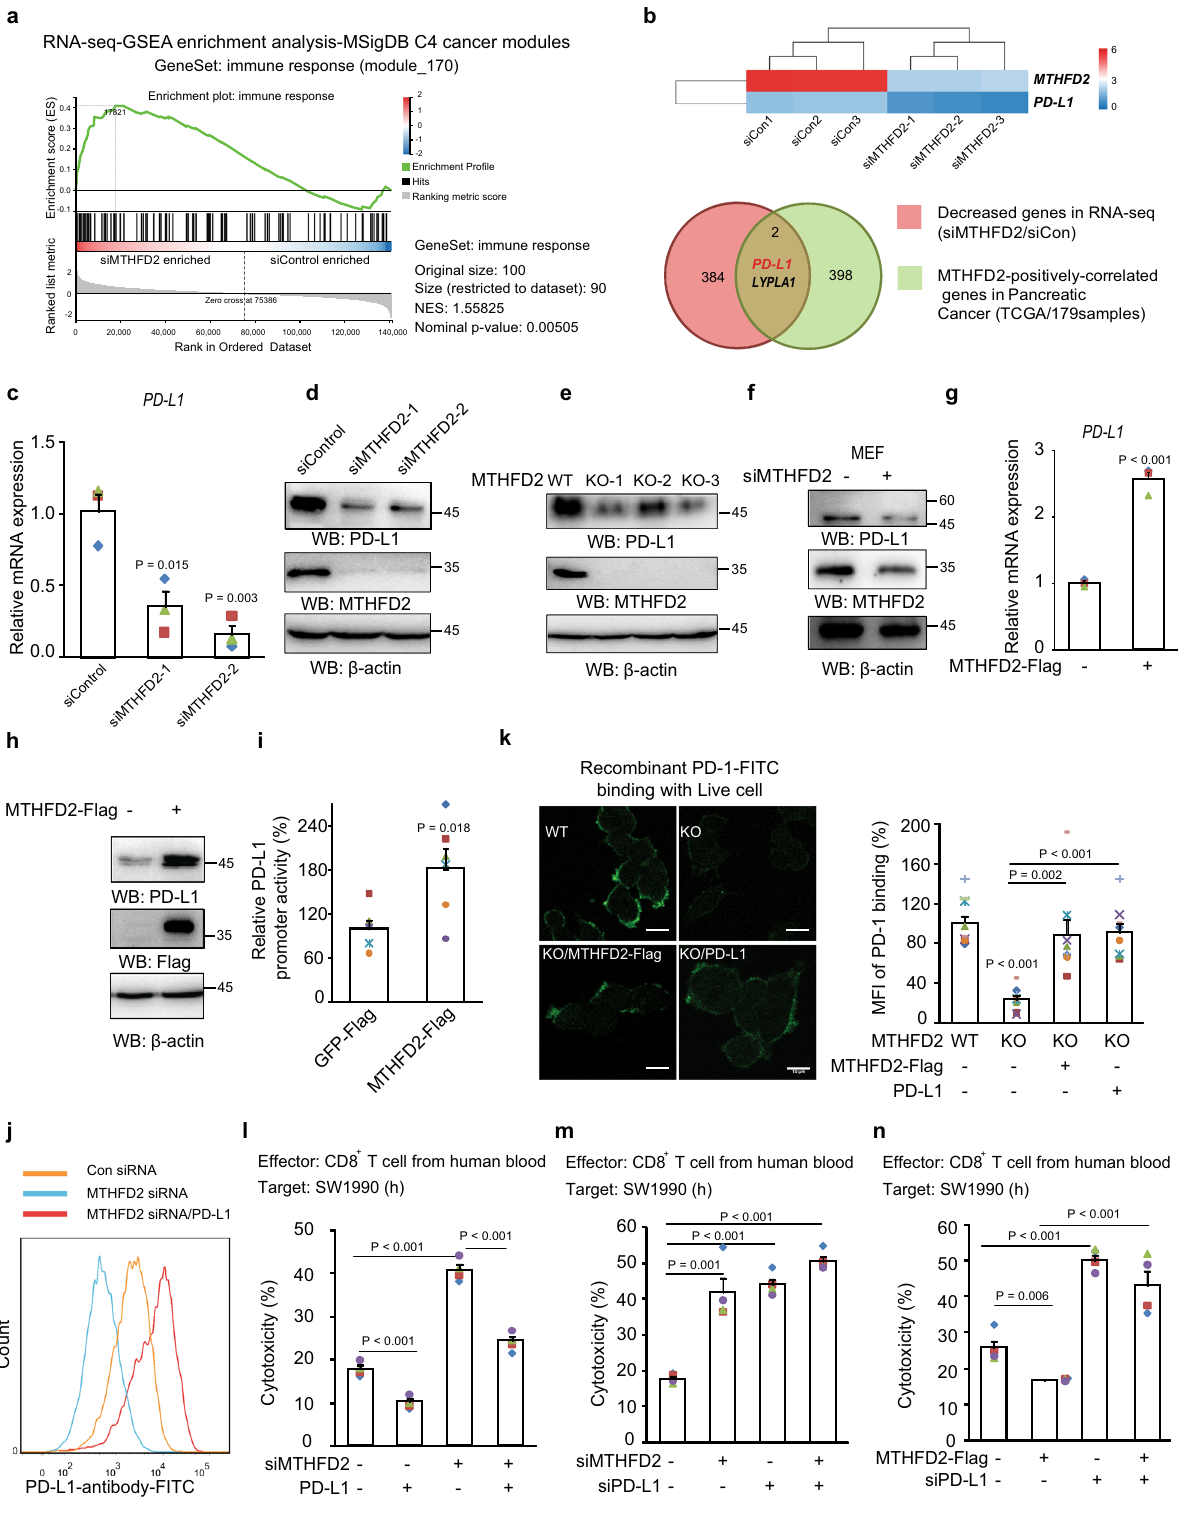
Fig. 4d, e and Supplementary Fig. 4a – f. The second most decreased metabolite, UDP, and its related metabolite UTP signi fi cantly upregulated PD-L1 protein (Fig. 4d, e) as well as mRNA (Fig. 4f, g) in a dose-dependent manner. Uridine also promoted PD-Ll, albeit to a lesser extent (Supplementary Fig. 4a).